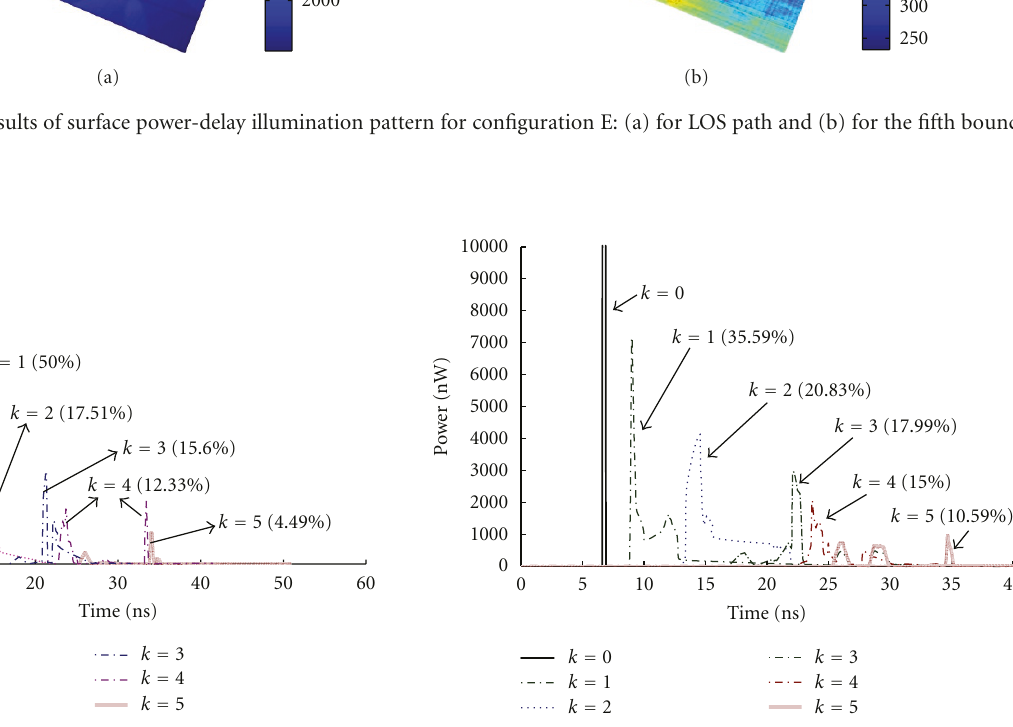
Figure 11: Impulse responses of configuration E for light undergo- ing up to five